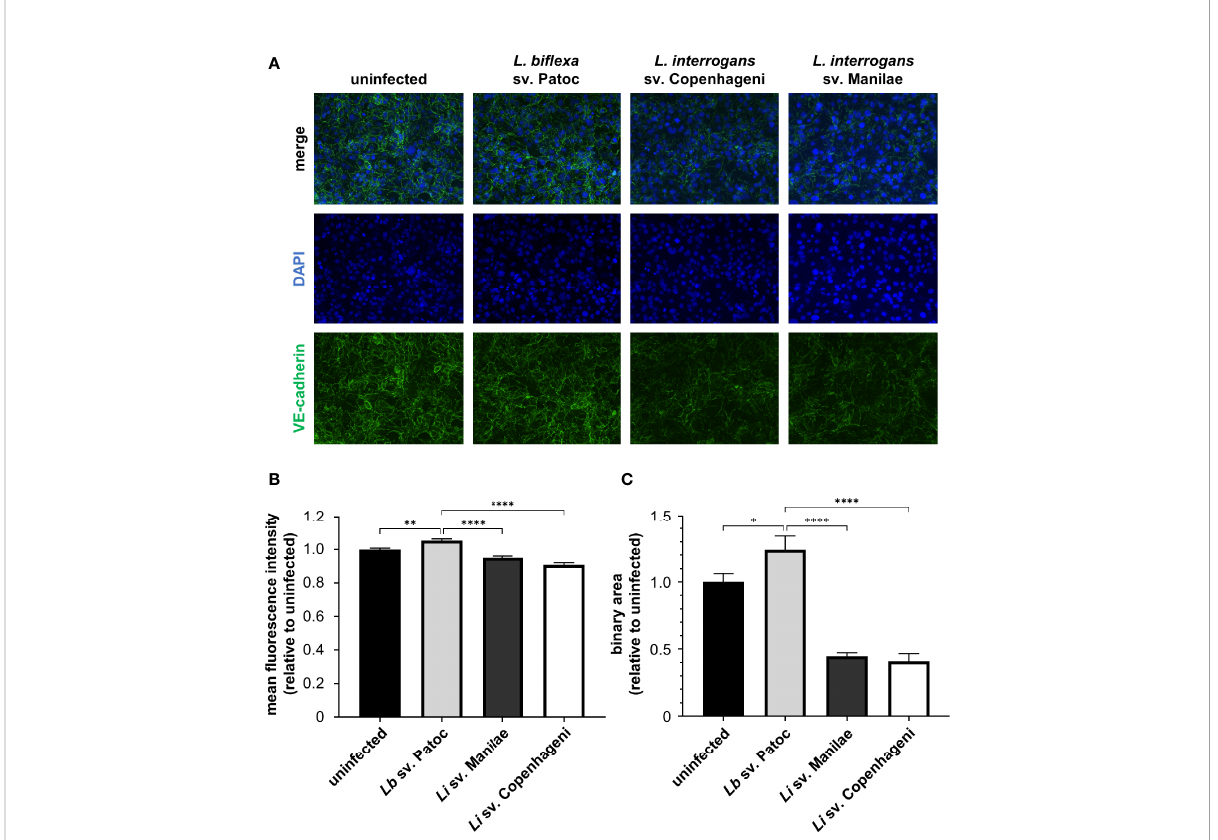
FIGURE 1 Pathogenic Leptospira disrupt VE-cadherin staining in adherens junctions (AJs). HMECs were grown to con fl uence on glass coverslips and infected at an MOI of 20 for 24 h. Cells were fi xed, stained for VE-cadherin (green), and mounted with Prolong Diamond Antifade Mountant with DAPI (blue). (A) Representative images highlight the change in VE-cadherin staining upon infection with various strains of Leptospira . (B) Mean fl uorescence intensity (m.f.i.) was quanti fi ed. Minimal decreases in VE-cadherin are seen upon treatment with pathogenic Leptospira . (C) Binary area of VE-cadherin was determined. Pathogenic Leptospira quantitatively decrease VE-cadherin localized in AJs. Data represent three independent experiments; 10 images per slide were taken and analyzed quantitatively for each experiment. Mean ± SEM is plotted. Each column is compared to the Lb sv. Patoc control. *denotes p ≤ 0.05, **denotes p ≤ 0.01, ****denotes p ≤